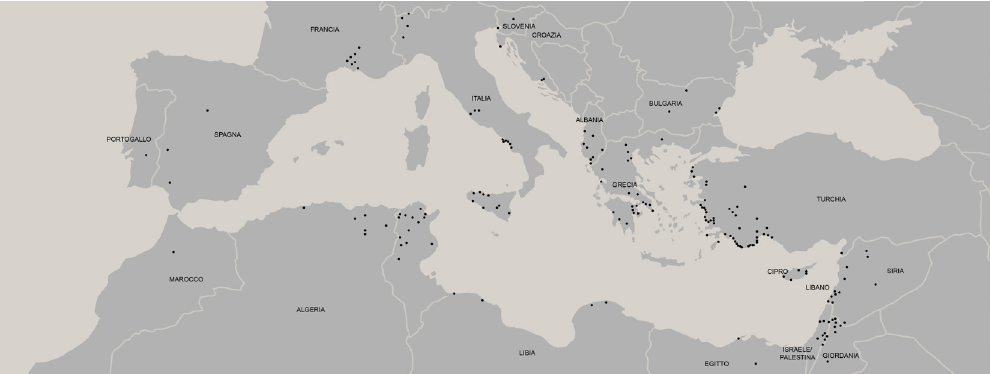
Fig. 2 Author, year, sites visited and photographed by Josef Koudelka between 1991 and